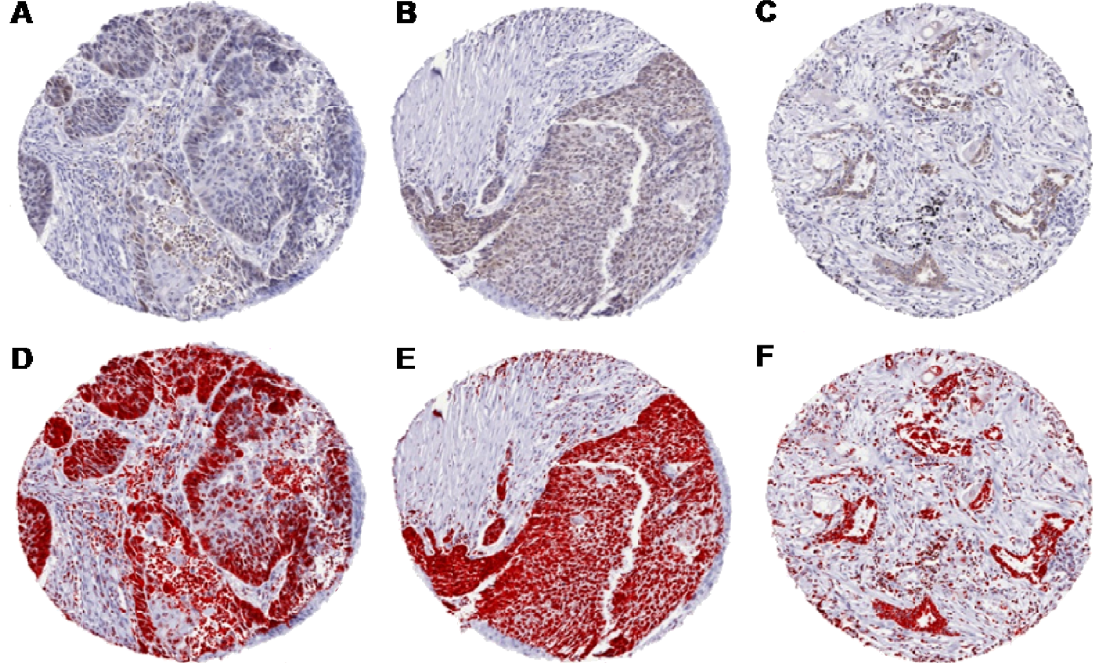
Fig. 9. Examples of biomarker quantification. A, B and C show 3 TMA core images, whereas D, E and F show their marked up DAB regions using overlapping red colour. (Colours are visible in the online version of the article; http://dx.doi.org/10.3233/ACP-CLO-2010-0551.)